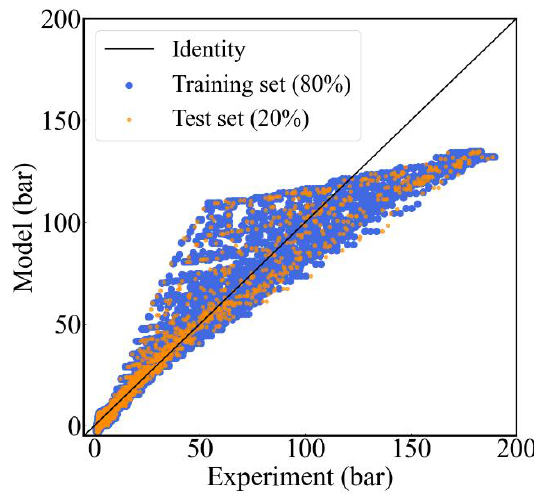
Figure 4. Regression analysis of the initialized XGB.